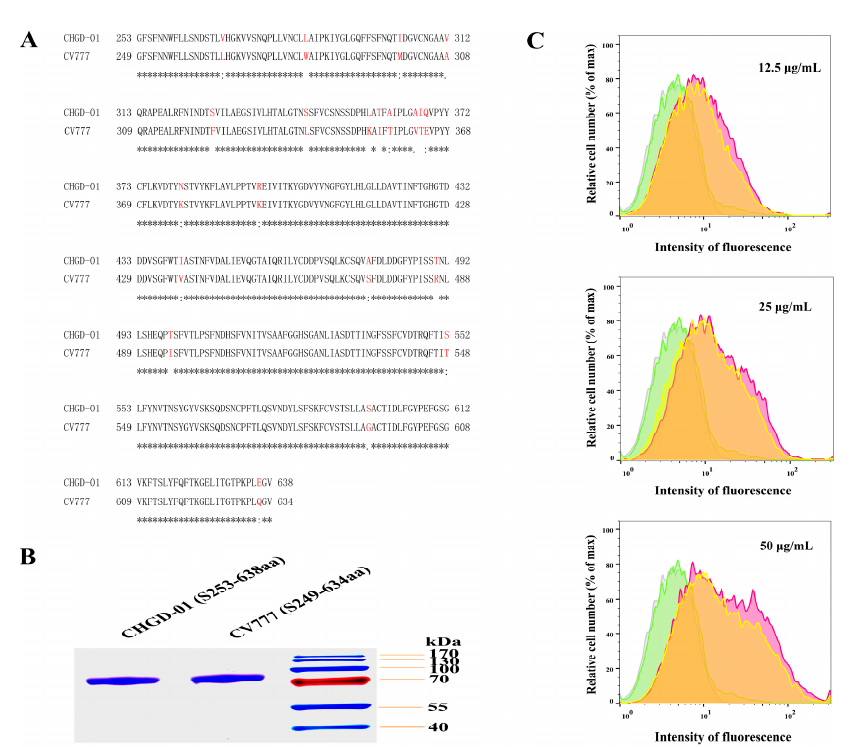
Figure 3. Comparison of pAPN-binding activity between CV777 and CHGD-01. ( A ) Sequence alignment of the CHGD-01 S 253 ´ 638 and the CV777 S 249 ´ 634 was carried out by ClustalW. The different residues are shown in red; ( B ) Purified proteins of the CV777 S 249 ´ 634 and the CHGD-01 S 253 ´ 638 with a C-terminal IgG 4 Fc tag were detected by SDS-PAGE; ( C ) The binding of the CV777 S 249 ´ 634 or the CHGD-01 S 253 ´ 638 with pAPN-expressing cells was investigated by flow cytometry. HEK-293T cells were transfected with a pAPN gene-containing plasmid. After 48 h, the cells were resuspended with different concentrations of the CHGD-01 S 253 ´ 638 protein (pink shade) or the CV777 S 249 ´ 634 protein (yellow shade), including 12.5 µ g/mL ( top ), 25 µ g/mL ( middle ), and 50 µ g/mL ( bottom ), followed by treatment with FITC-labeled anti-human IgG 4 Fc antibodies. Then FACS was performed. pAPN-transfected cells untreated with protein (grey shade) or treated with IgG 4 Fc protein (green shade) were used as